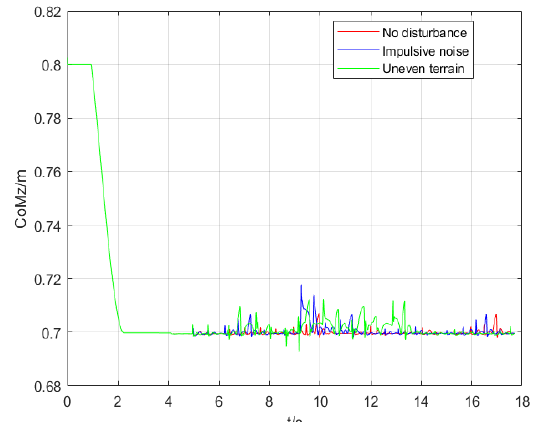
Figure 9. Variation in the height of the CoM.